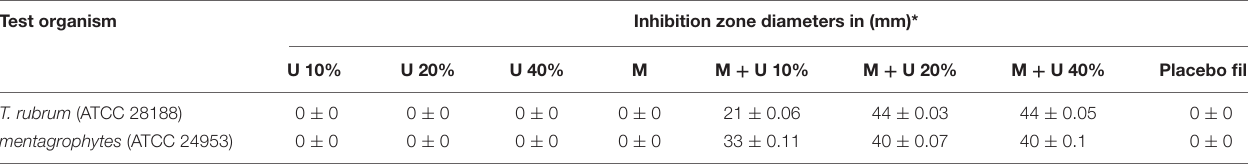
TABLE 4 | Assessment of T. rubrum and T. mentagrophytes growth inhibition by drug-containing water-soluble films using disc diffusion assay. Test